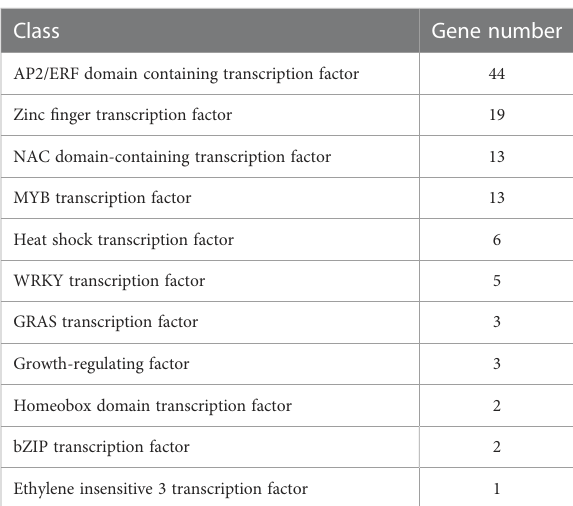
TABLE 5 Classi fi cation of transcription factor genes differentially expressed at all time points (|log2FoldChange| > 1 and padj < 0.05) upon freezing